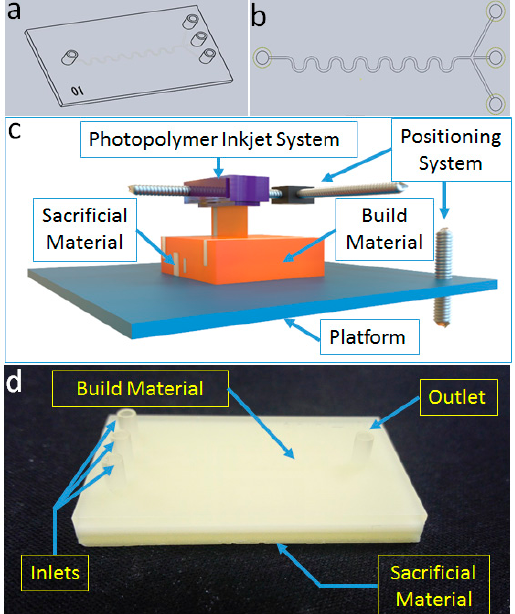
Figure 1. Design and fabrication of three-dimensional (3D)-printed microfluidic chips. ( a ) A microfluidic chip with a serpentine channel. ( b ) A 3D chip model designed by SolidWorks. ( c ) Schematic of the polyjet 3D printer with three main parts, including the photopolymer inkjet system, the positioning system, and the forming platform. ( d ) 3D printed chips with build materials and sacrificial materials.